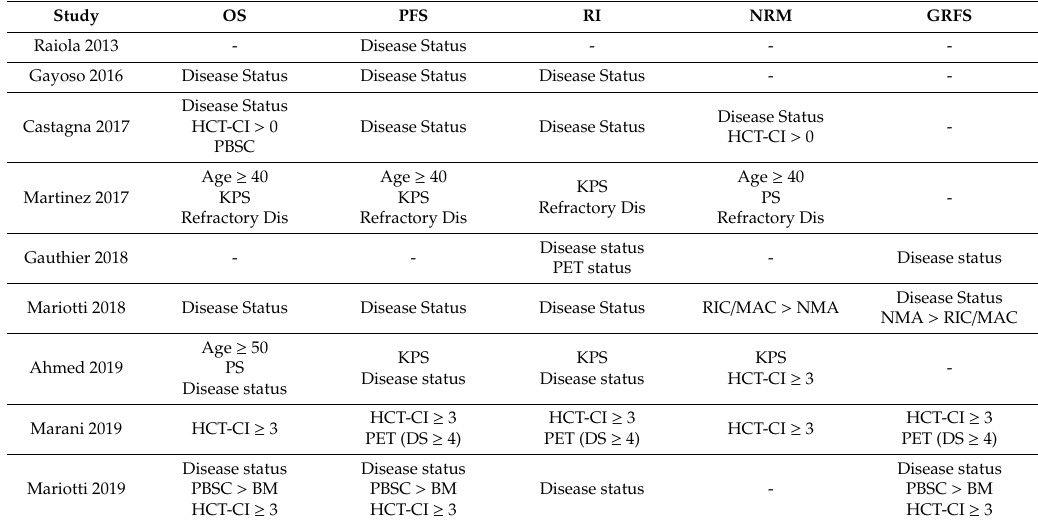
Table legend: OS: overall survival; PFS: progression free survival; NRM: non-relapse mortality; RI: relapse incidence; GRFS: GVHD / relapse-free survival; HCT-CI: hematopoietic cell transplant-comorbidity index; KPS: karnofsky performance status; Dis: disease; PS: performance status; DS: Deuville score; PBSC: peripheral blood stem cell; BM: bone